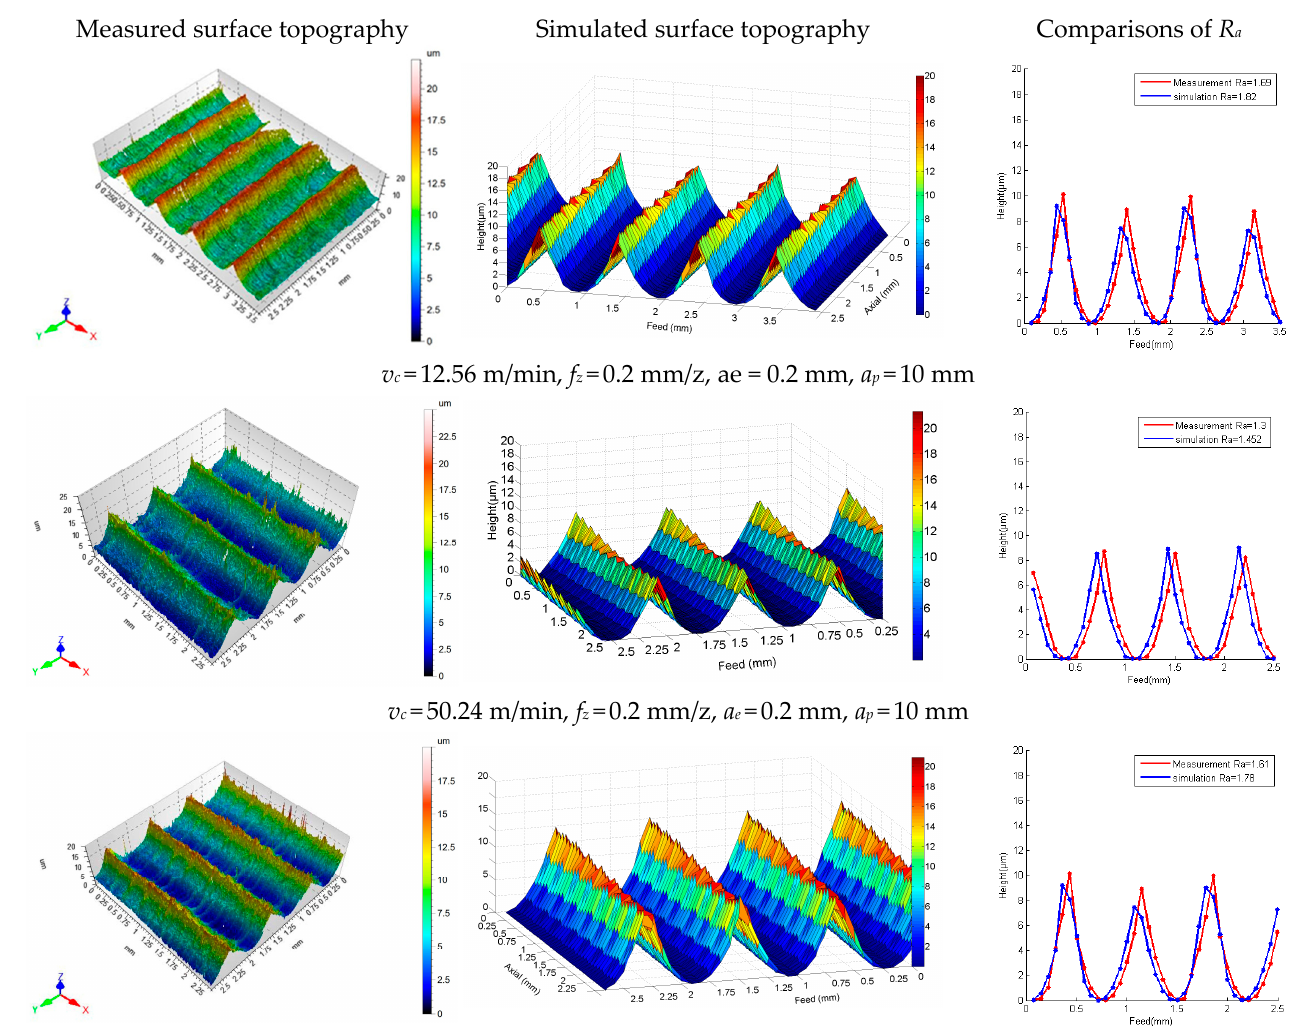
Figure 14. Surface topography at different milling speeds.